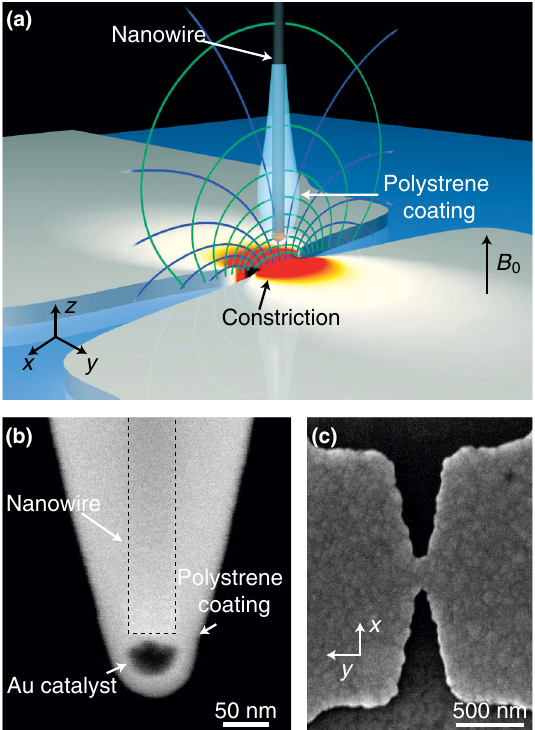
FIG. 1. Experimental apparatus. (a) Schematic of the experi- mental setup. A silicon nanowire coated with polystyrene is positioned near the constriction in a Ag current-carrying wire. The locally high current density through the constriction gen- erates intense fields and gradients used for readout, spin ma- nipulation, and spatial encoding. During imaging, the spin density is encoded along contours of constant Larmor and Rabi frequencies, which are illustrated as blue and green lines, respectively. (b) Scanning electron micrograph of a representa- tive nanowire and polystyrene coating prepared in the same manner as the nanowire and sample used in this study. The actual nanowire and sample used here were not imaged in order to avoid electron damage. The dashed lines indicate the outer diameter of the nanowire. (c) Scanning electron micrograph of the constriction used in this study. The constriction, which appears in light gray in the image, is 100 nm thick and 240 nm